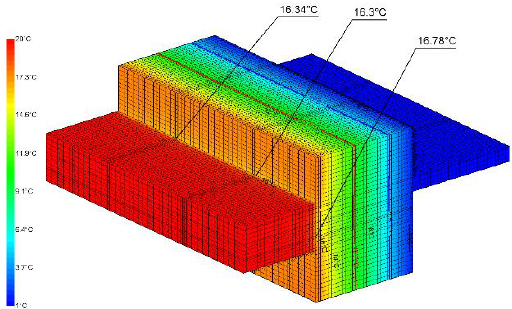
Figure 16. Internal surface temperature distribution field on the wall and deck—top view.